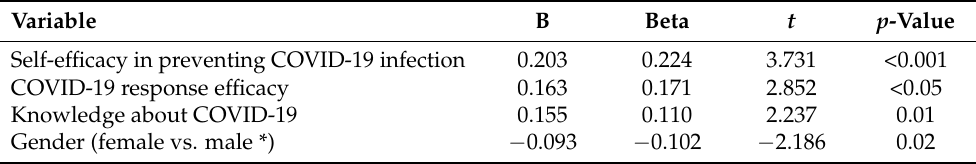
Table 3. Results of the stepwise multiple regression analysis of the factors with an influence on and ability to predict the COVID-19 preventive behaviors of the study participants.